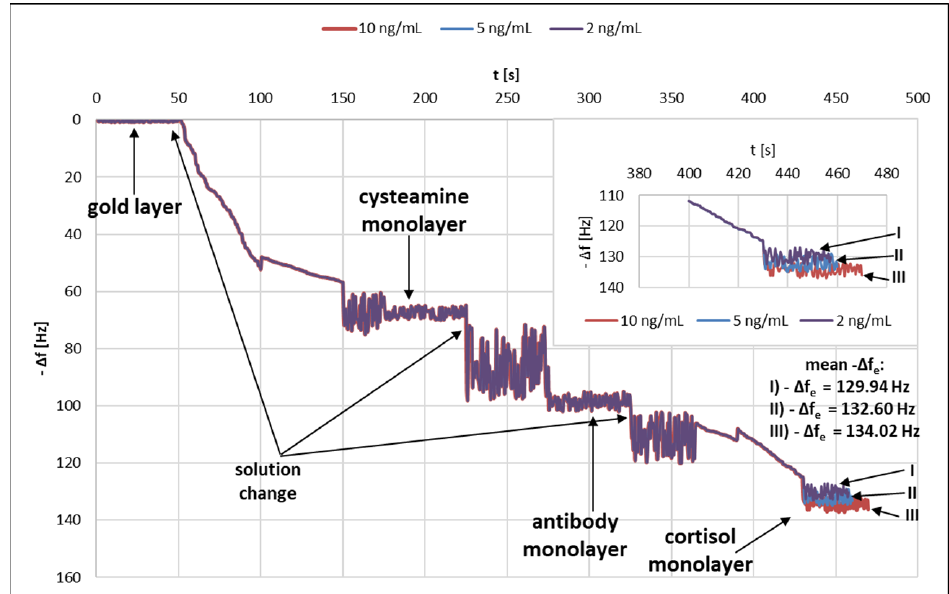
Figure 4. Variation of frequency as a function of time.